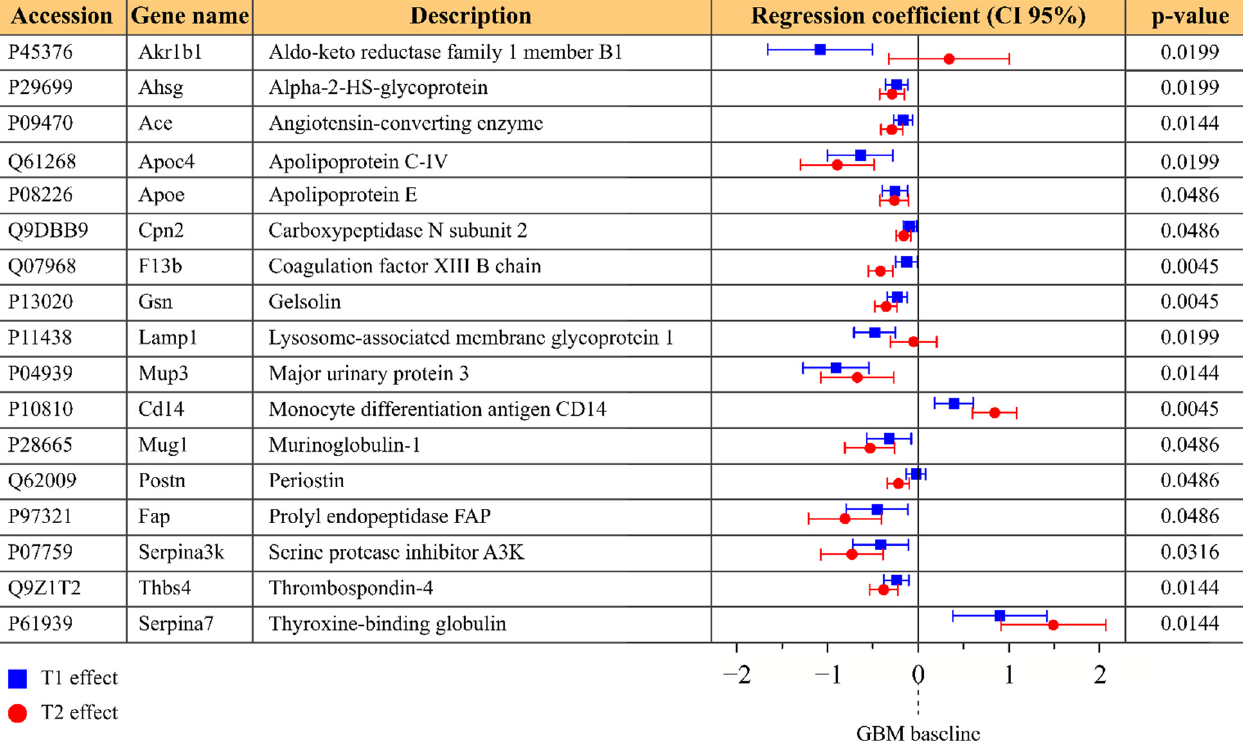
Figure 2. Protein groups that exhibited significant differences in the serum dataset; p -values refer to the H0 hypothesis that all coefficients of the model are zero. Regression coefficients are reported in blue for a T1 (pre-symptomatic) effect and in red for a T2 (symptomatic) effect, with their confidence interval at 95%. Regression coefficients represent the fold change compared to the baseline.